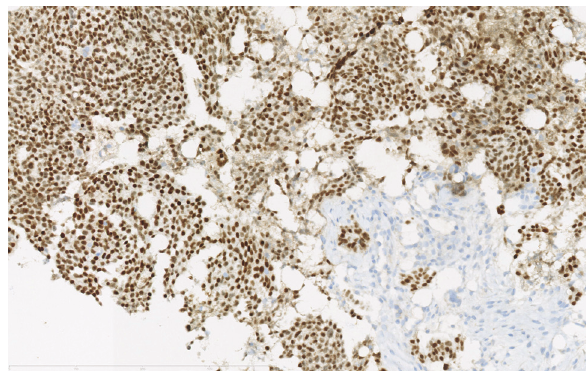
Figure 1B. Biopsy of the breast metastasis. 20× magnification. Positive staining PAX8 on immunohistochemistry: Nuclear staining dark brown in tumor cells of ovarian origin within the mammary stroma stained